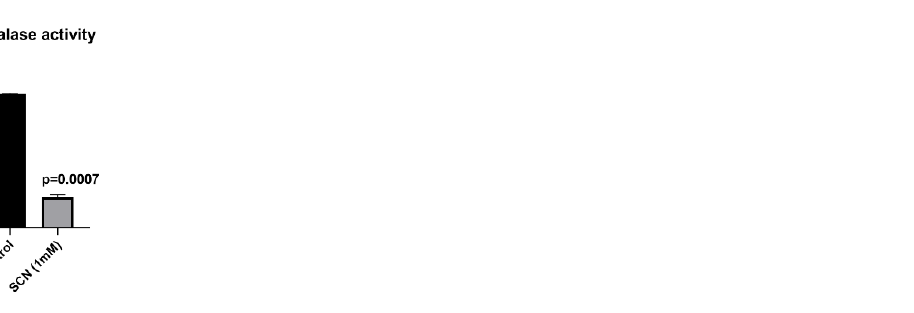
Figure 4. Thiocyanate ( − SCN) switches AEOL10150 hydrogen peroxide scavenging from a dismu- tation to a peroxidase reaction. Samples were incubated with 1 mM H 2 O 2 and 50 µ M of 10150(Cl) in the presence or absence of 1 mM NaSCN, and oxygen formation was measured over 5 min using an oxygen electrode.